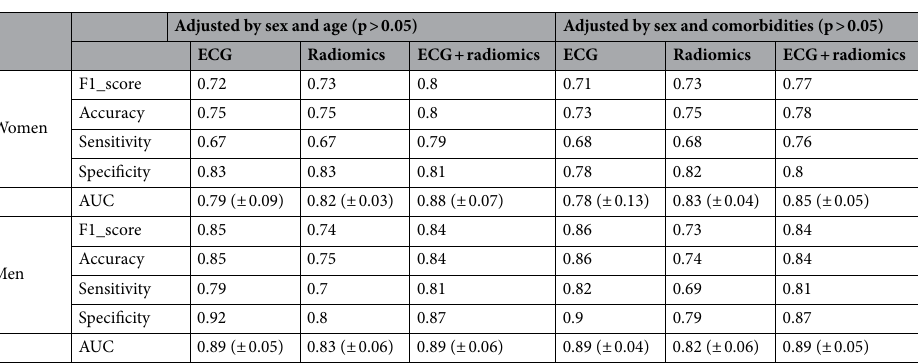
Table 7. Average performance of the models for all AF patients adjusted by sex and age only, and sex age and other comorbidities. The standard deviation is indicated in parenthesis.